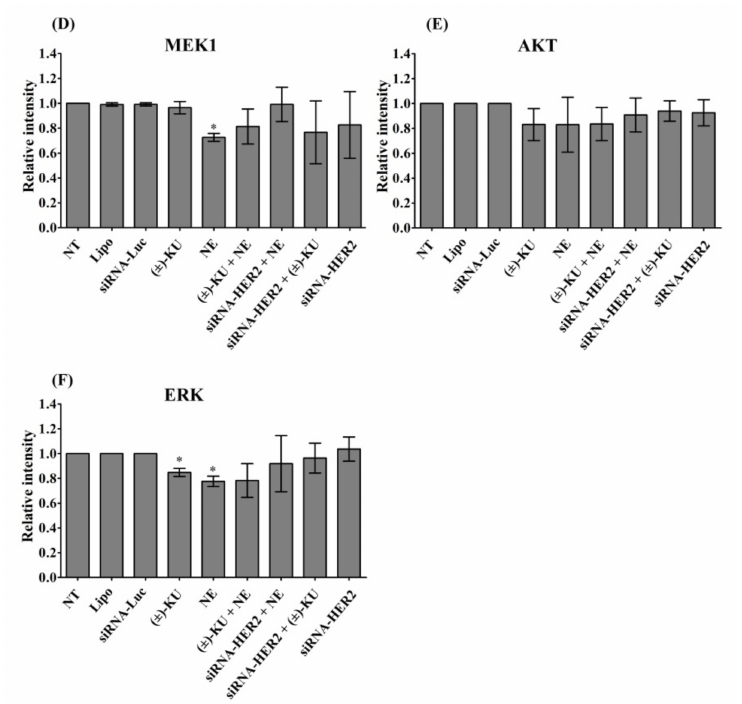
Figure 6. Effect of synthetic ( ± )-kusunokinin on HER2 and its downstream proteins. MCF-7 cells were treated with synthetic ( ± )-kusunokinin (4.45 µ M), neratinib (0.004 µ M), a combination of synthetic ( ± )-kusunokinin and neratinib, or100 nM siRNA-HER2 for 48 h. For the combination of siRNA the with compound, cells were incubated with 100 nM of siRNA-HER2 for 24 h followed by treatment with 4.45 µ M ( ± )-kusunokinin, or 0.004 µ M neratinib for 48 h. The negative controls were non-treated cells, lipofectamine and siRNA-luciferase treatments. ( A ) After incubation, cells were harvested and lysed by RIPA buffer. Total protein was subjected to SDS-PAGE and proteins of interest were determined using Western blot analysis. GAPDH served as an internal control. The quantitative proteins of interest, including ( B ) HER2, ( C ) Ras ( D ) MEK1, ( E ) AKT, and ( F ) ERK, were calculated by normalized with GAPDH band intensity. Data are representative of three independent experiments. All graphs show mean ± S.D. The student’s t -test was used for consideration of p values < 0.05. * p < 0.05 vs. control. NT, non-treated cells; Lipo, lipofextamine; siRNA-Luc, siRNA-Luciferase; ( ± )-KU, ( ± )-kusunokinin; NE, neratinib; ( ± )-+NE, +( ± )-kusunokinin+neratinib; siRNA-HER2+NE,